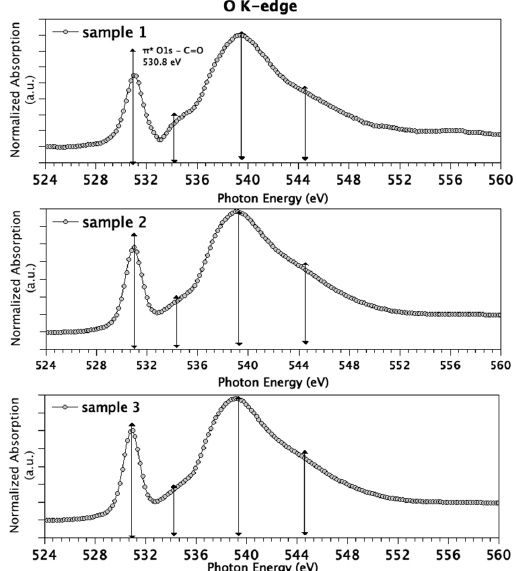
Figure 2. C K-edge spectra measured for Sample 1 ( top ), Sample 2 ( middle ) and Sample 3 ( bottom ).